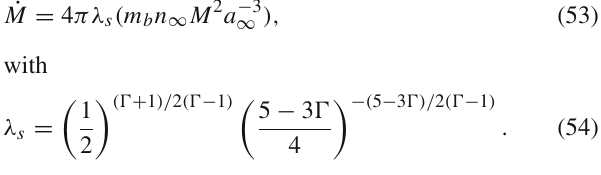
into Eq. (51), this gives the well-known result derived